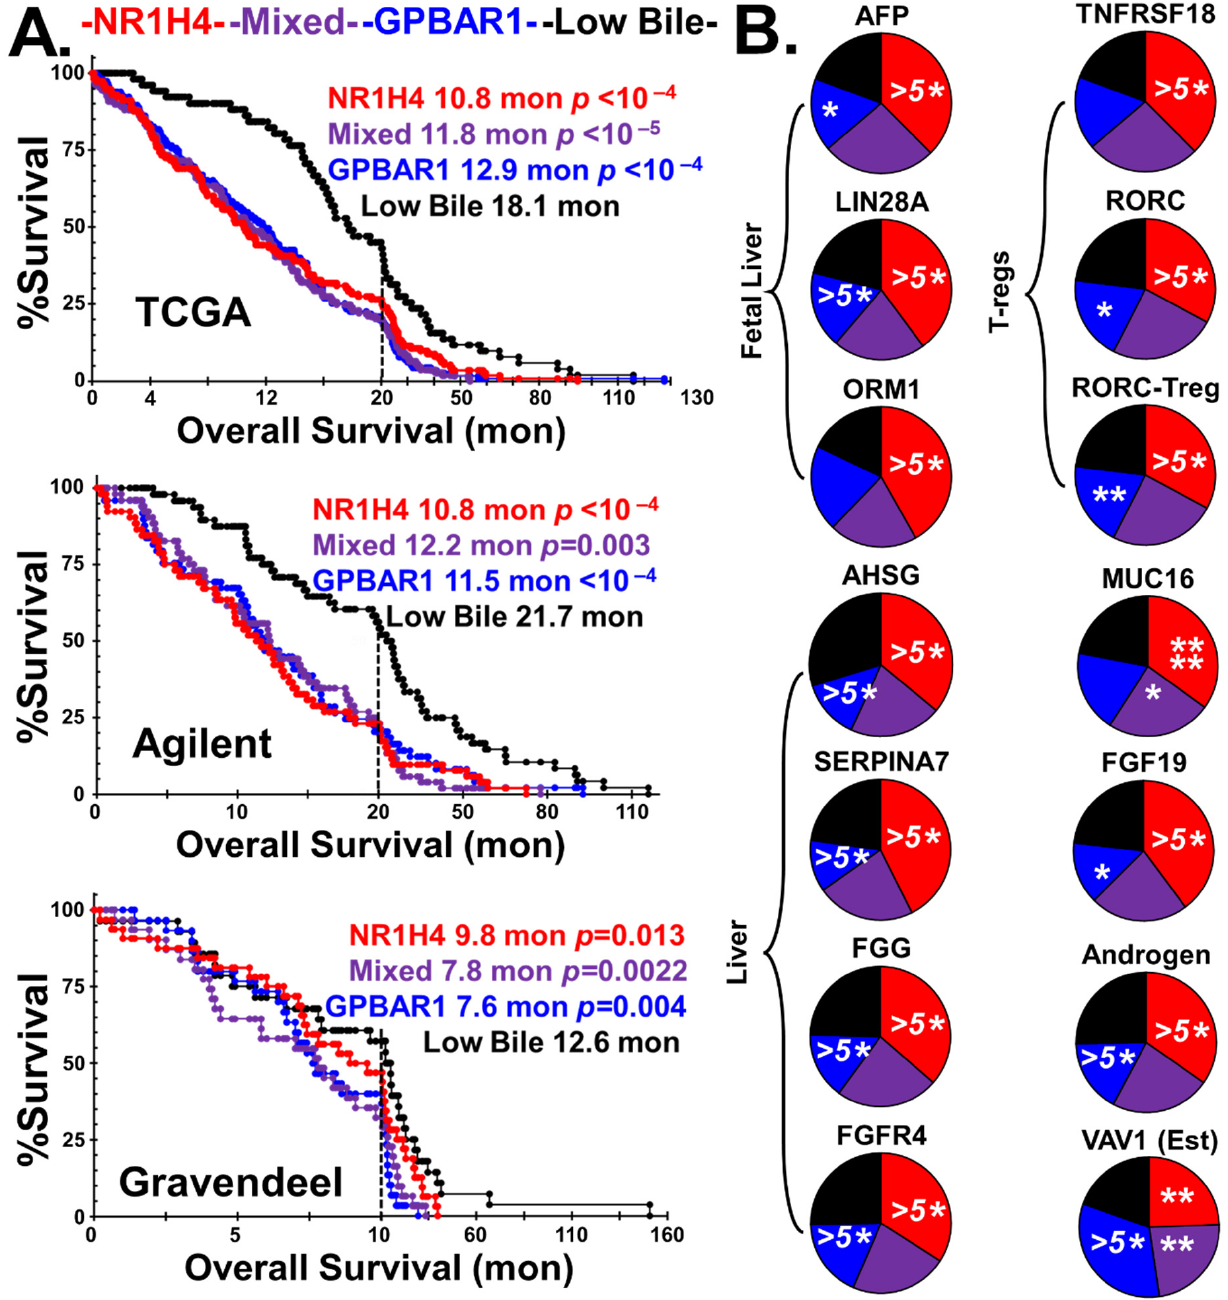
Figure 6. Bile salt impacts patient survival and the fetal liver phenotype of GBM. ( A ) Bile synthe- sis/receptor phenotypes’ impact on patient outcome is shown in the Kaplan–Meier survival analysis. The patient population with the worst outcomes are those that synthesize bile at > 80%, and those with low bile synthesis have better survival characteristics. ( B ) Pie charts show that the distribution of markers of the fetal and adult livers are predominantly in the NR1H4-rich tumors (Red). The NR1H4-rich tumors are infiltrated with RAR Related Orphan Receptor C (RORC)-rich Tregs and have elevated RORC-Treg target mucin 16 (MUC16), and high expression of the bile-sensitive hormone fibroblast growth factor 19 (FGF19). In addition, the NR1H4-rich tumors have an androgenic signature in contrast to the GPBAR1 receptor-rich tumors (Blue), which are estrogenic, clustering with estrogen reporter genes, such as vav guanine nucleotide exchange factor 1 (VAV1). p < 0.05 *, p < 0.01 **, p < 0.001 ****, and p < 0.0001 (5 * ) In contrast, the GPBAR1 receptor-rich tumors (Blue) are estrogenic, clustering with estrogen reporter genes, such as vav guanine nucleotide exchange factor 1 (VAV1). Tu- mors enriched within the GPBAR1 are more heavily infiltrated with microglia, TAMs, and MDSCs, than tumors enriched with NR1H4, Figure 7. This corresponds to the previously observed enrichment in estrogenic tumors [1].